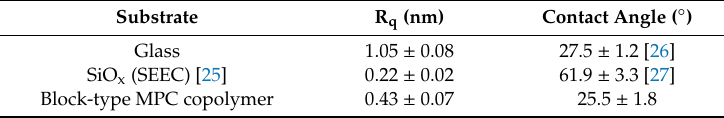
Table 1. Roughness and contact angle of the di ff erent substrates.